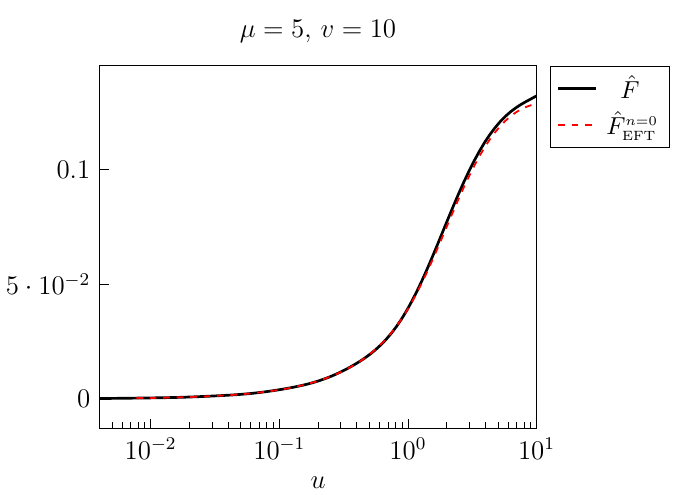
ˆ associated with a very heavy F n =0 EFT